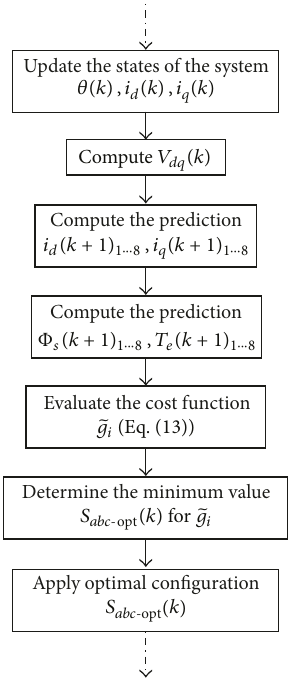
Figure 7: Flowchart of the NMP-DTC